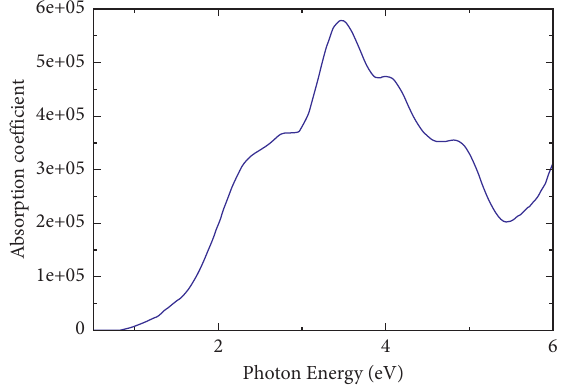
Figure 3: Absorption coefficient against photon energy (0–6eV).